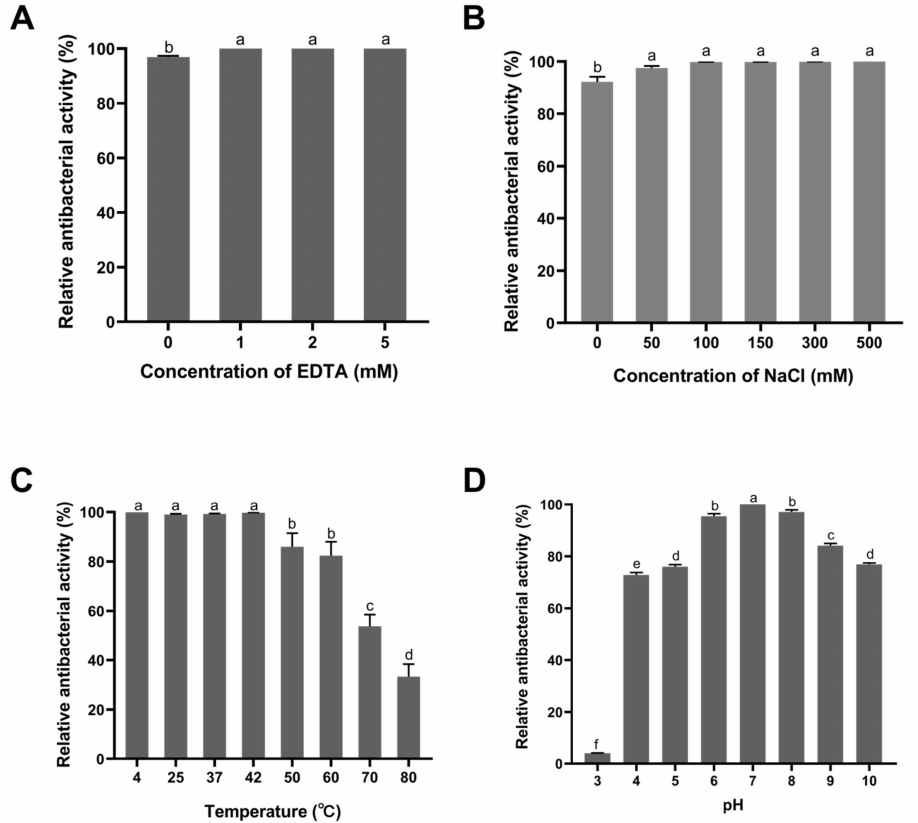
Figure 4. Effects of key parameters on the lytic activity of recombinant Plychap001. Lytic activity of Plychap001 (0.1 mg/mL) against V . Parahaemolyticus 17802 in varying ( A ) concentrations of EDTA, ( B ) concentrations of NaCl, ( C ) temperature, and ( D ) pH value. Different letters (a–f) on the columns indicate significant difference between each other at p < 0.01 level. Data were shown as the mean ± SEM for n =